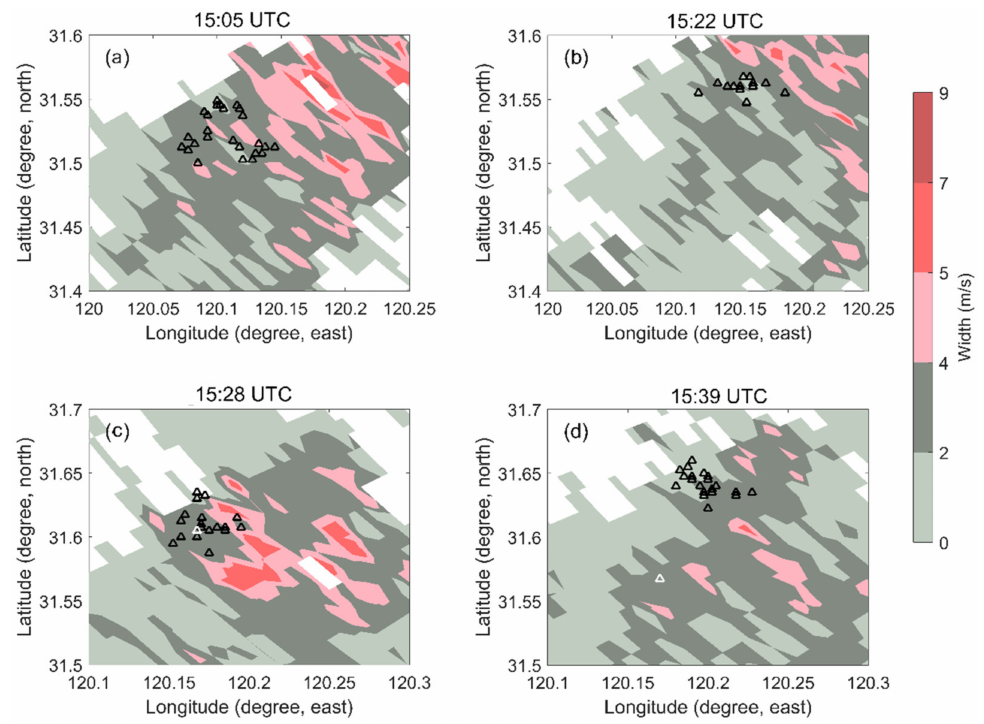
Figure 6. Locations of NBEs overlapped on the spectrum width with the elevation angle scans of 6 ◦ (15–17 km). ( a – d ) present the outbreak of negative NBEs overlapped on spectrum in different time of